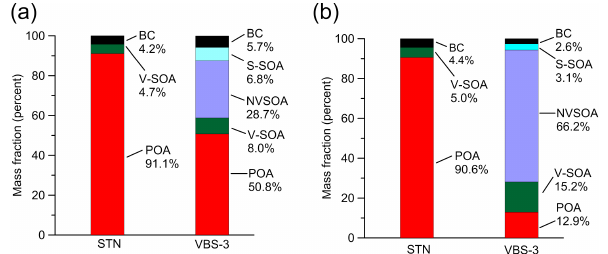
Figure 11. (a) Top-down estimates (in Tg) of total BB aerosol emis- sions from the study region in the period from 1 July to 31 Au- gust 2010 according to different simulation scenarios and in com- parison with total particulate matter (TPM) emission data from the GFASv1.0 and GFED3.1 inventories. The estimates are derived from the MODIS AOD measurements. (b) The corresponding opti- mal estimates of F α derived from MODIS (boxes with solid filling) measurements in comparison with corresponding estimates (boxes with dashed filling) obtained from ground-based measurements in the Moscow region. Note that the estimates for the “unrealistic” sce- nario “VBS-5”, which would exceed the axis limits (see Sect. 3.4), are not